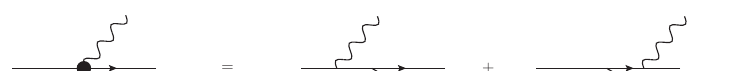
Figure 1: Schematic illustration of the current j W which describes the production of a W boson from a quark line with an off-shell gluon (shown as a zigzag